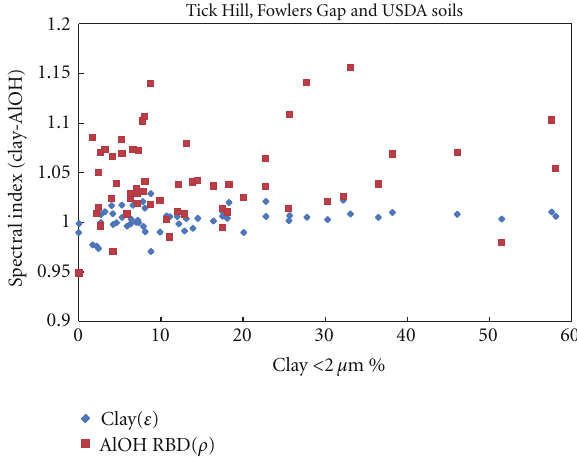
Figure 13: Comparison between the SWIR derived, AlOH RBD( ρ ), and TIR derived, Clay( ε ), mineral spectral indices, and the clay particle size content supplied by